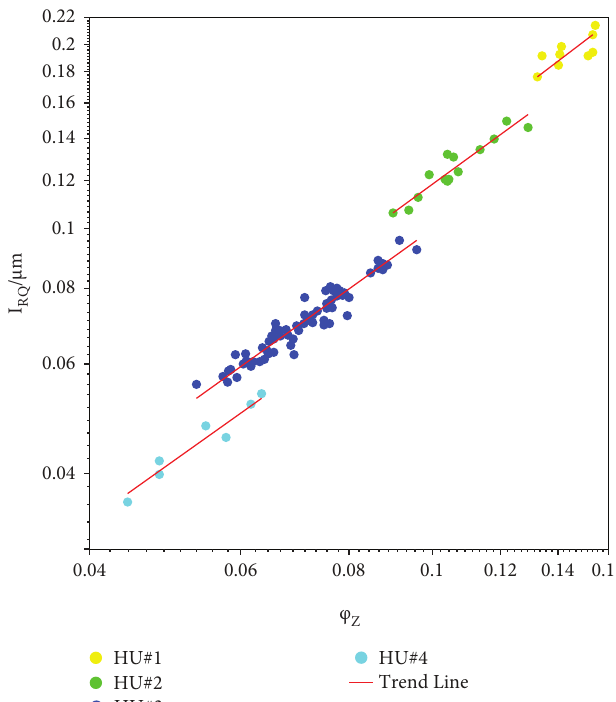
Figure 3: The clustering results of hydraulic units and the fitting trend lines of each unit.